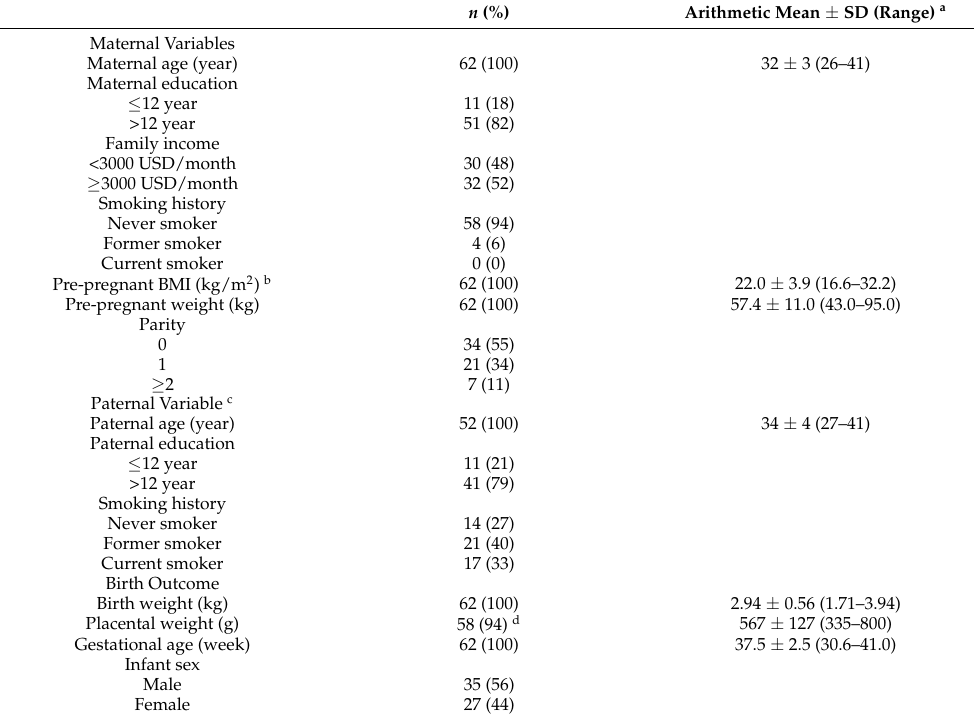
Table 1. Characteristics of the study